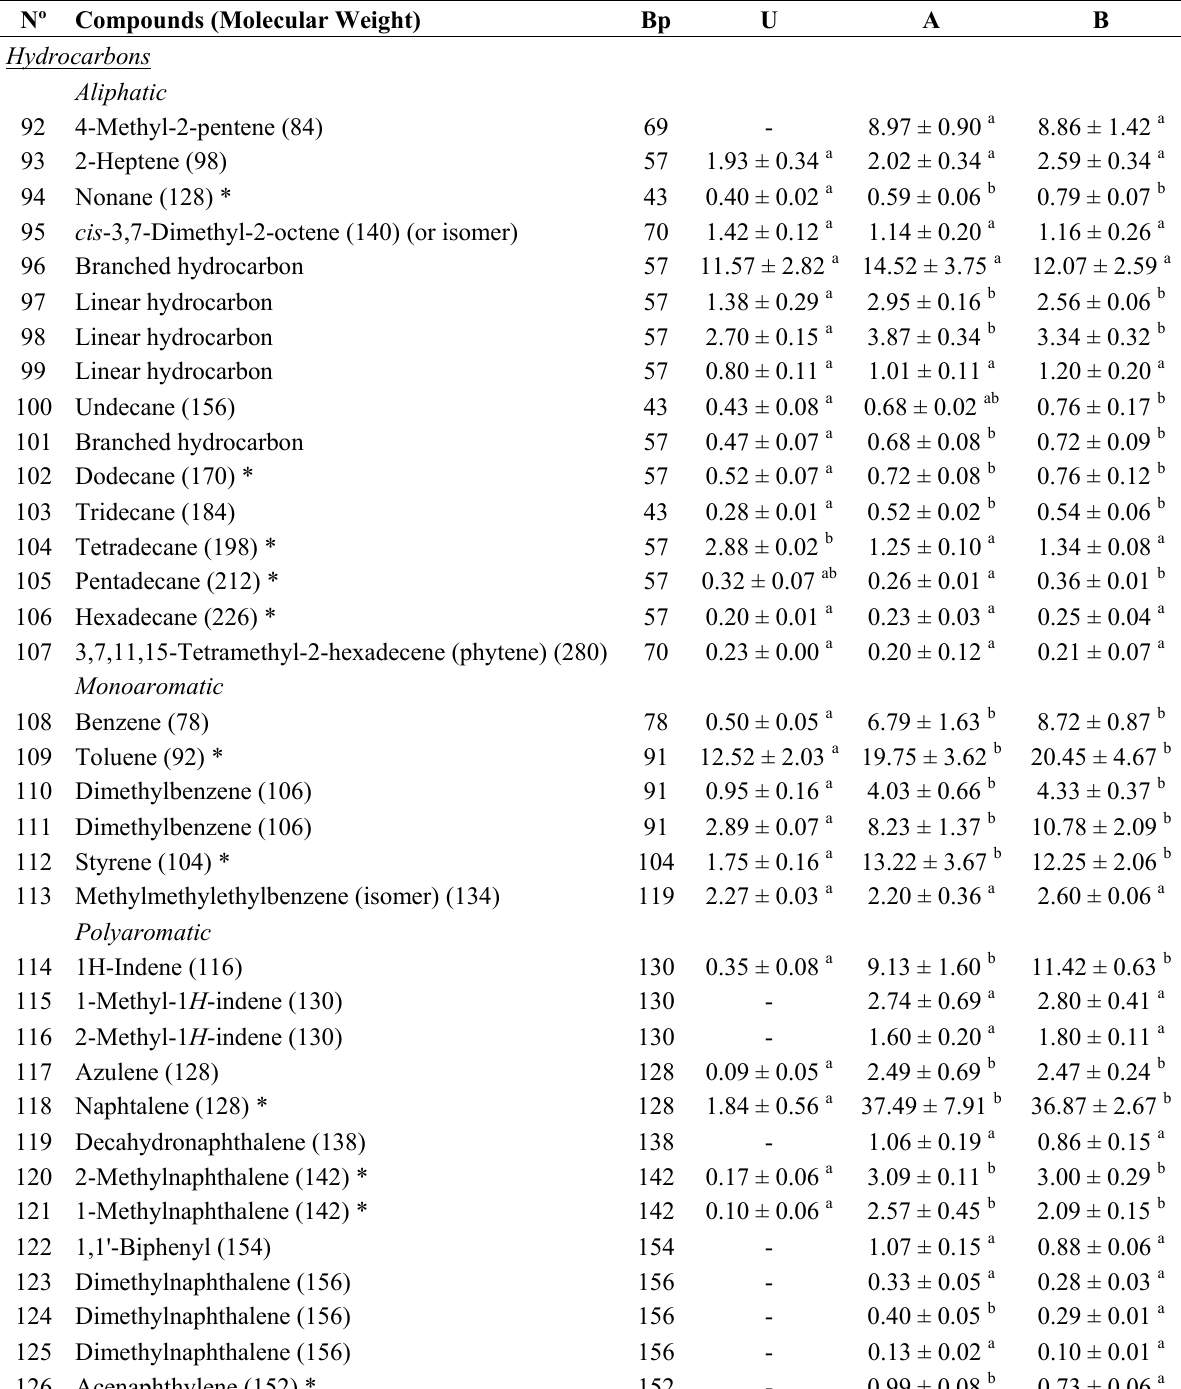
Table 3. Hydrocarbons, terpenes and sesquiterpenes detected in the headspace of the exterior region of unsmoked (U) and smoked (A and B) Herreño cheeses studied, together with their molecular weight, the base peak of their mass spectra (Bp), their abundance, expressed as average area counts of their mass spectra base peak divided by 10 5 , and standard deviation a